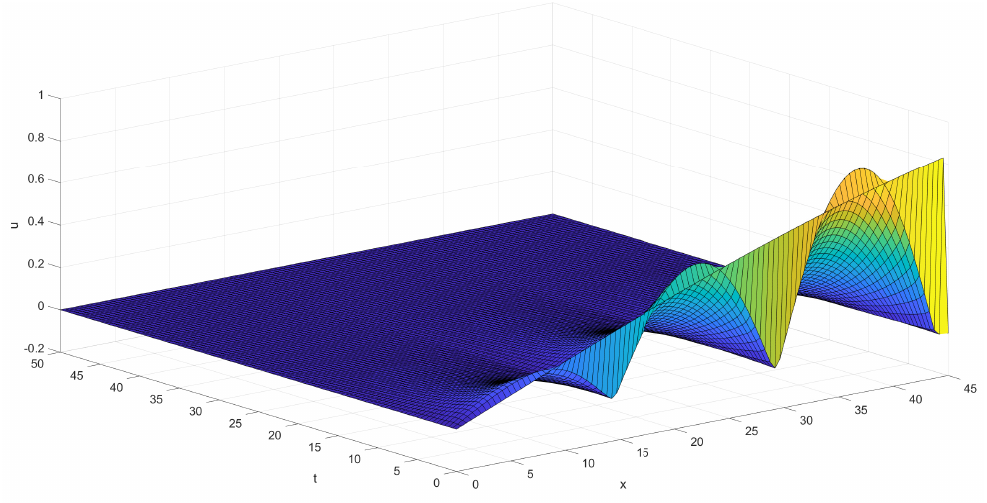
Figure 6. Decay in the simplest one-stage